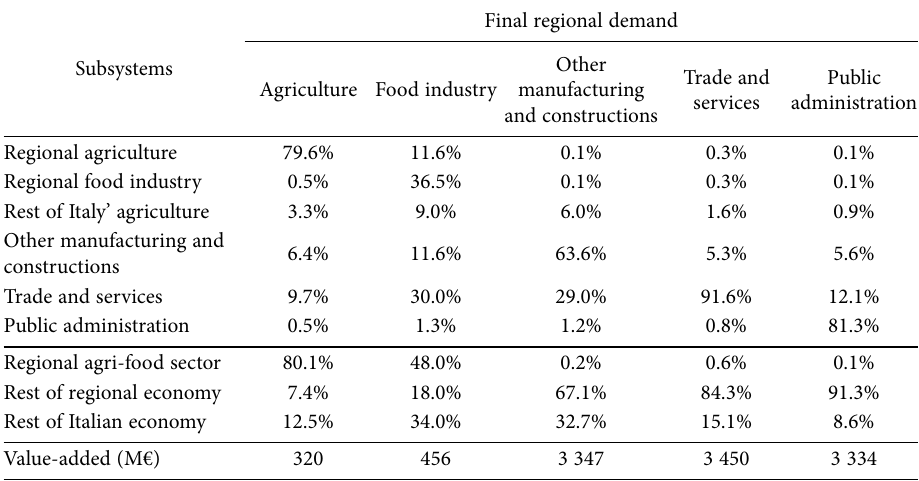
Table 6. Composition of subsystems in terms of value-added: macro-sectors.